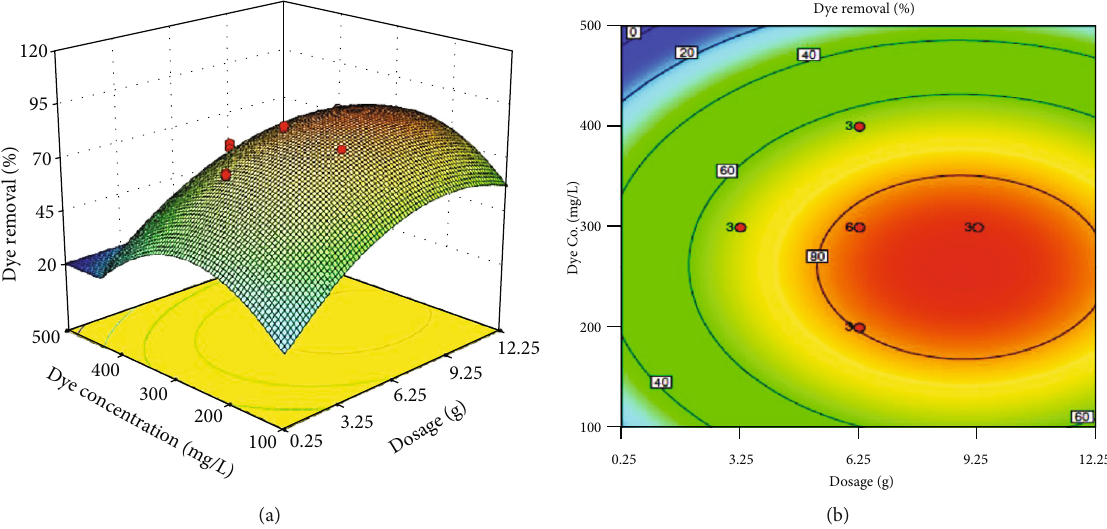
Figure 5: 3D response surface and 2D contour plots show the e ff ect of dosage and dye concentration on the RR2 removal.